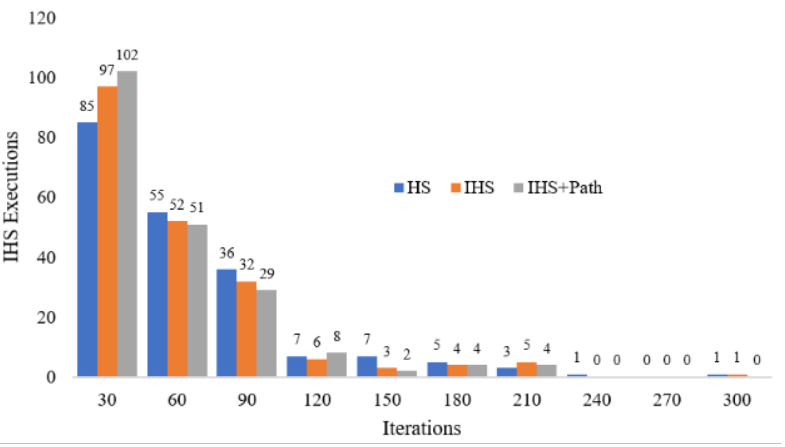
Figure 3. Convergence frequency of different algorithms for the 14-bus test system.